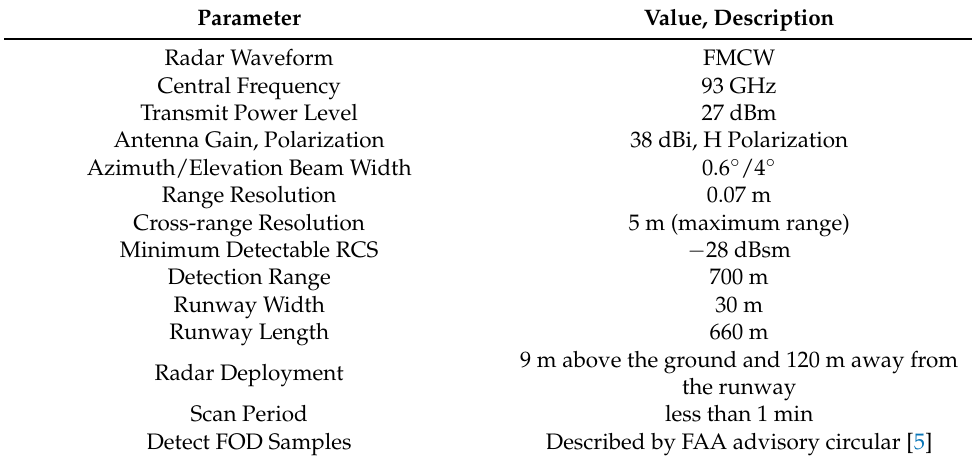
Table 2. AIRCAS designed FOD radar parameters.